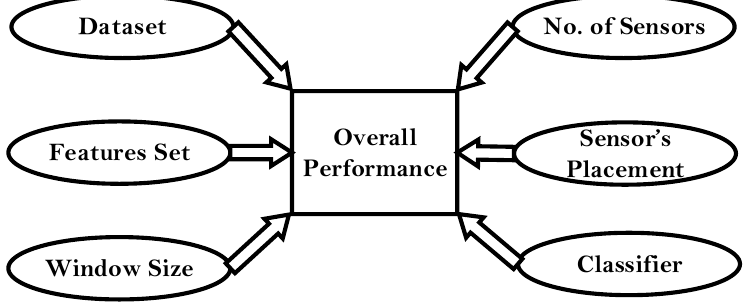
Figure 1. Factors that contribute to the overall performance of the PAC system.